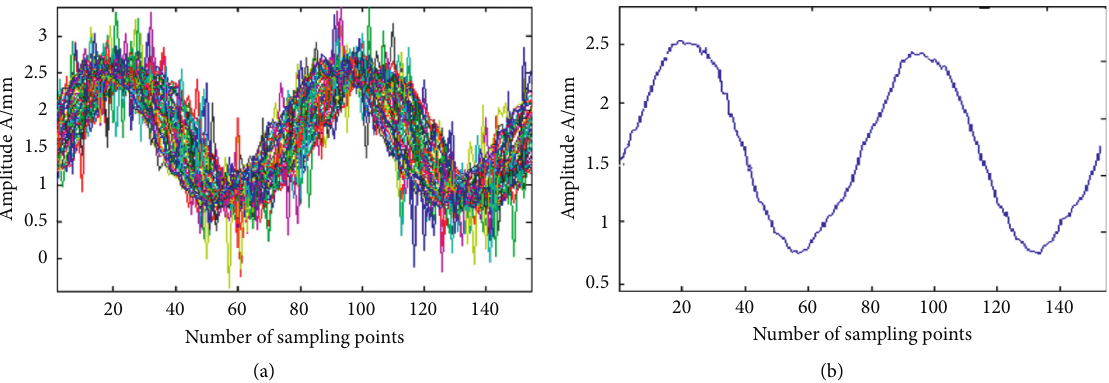
Figure 8: Traditional TDA processing results. (a) Synchronous correction data segment before improvement and (b) stacking average result.